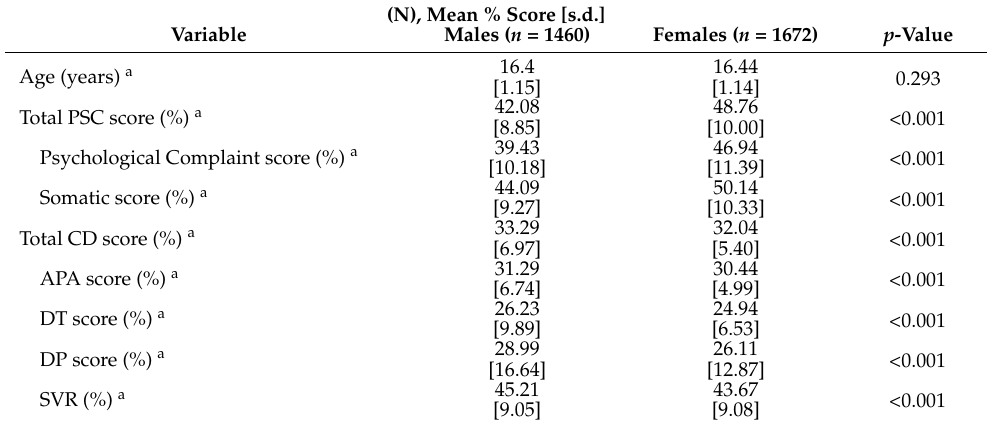
Table 2. Demographics (age, gender), PSC and CD scores of the total Uppsala Cross-sectional Life and Health Young Survey (LHS) study cohort ( n =